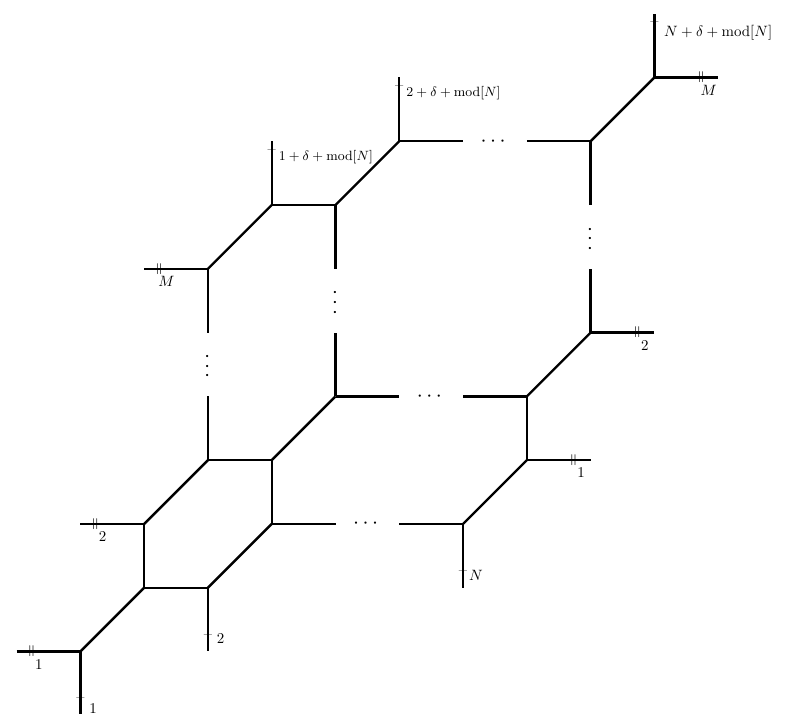
Figure 7 . Toric web diagram with a shifted identi(cid:12)cation of the external legs for (cid:14) 2 [0 ; N (cid:0)